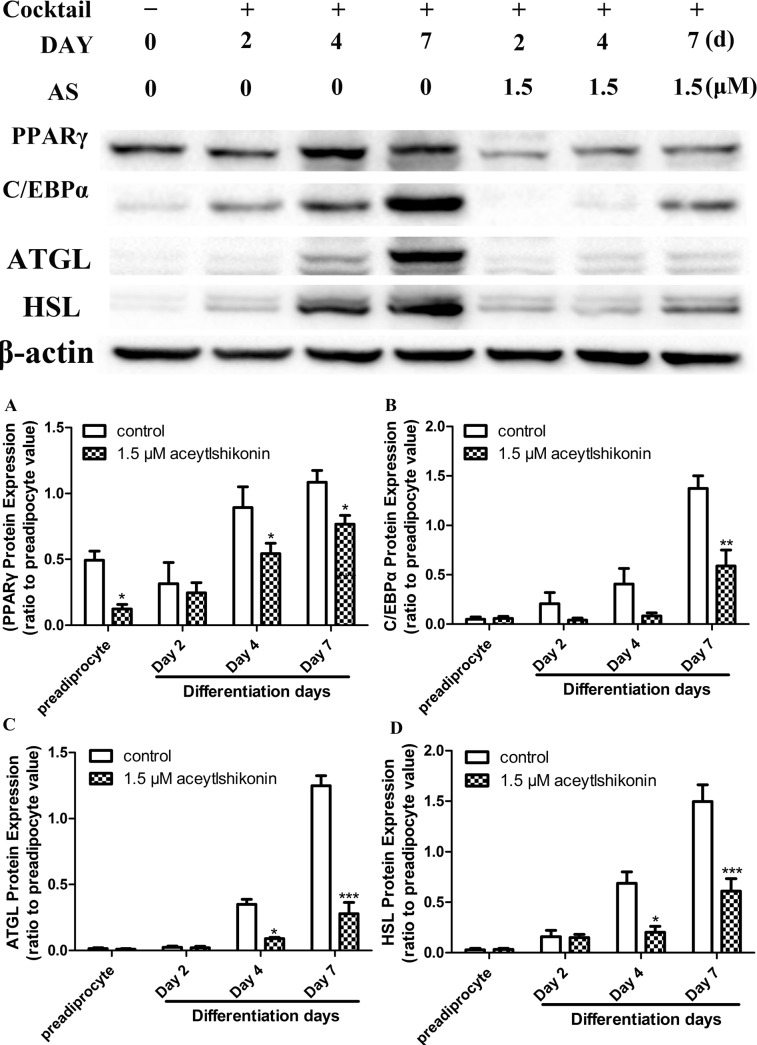
AS inhibits PPARγ, C/EBPα, HSL, and ATGL expression in adipocytes.Protein levels were assessed by western blotting in 3T3-L1 cells cultured for 0, 2, 4, and 7 days in the presence or absence of 1.5 μM AS during adipogenesis. Immunoblots are representative of five independent experiments; β-actin served as a loading control. *P < 0.05, **P < 0.01, ***P < 0.001 vs. untreated adipocytes at the same time point.